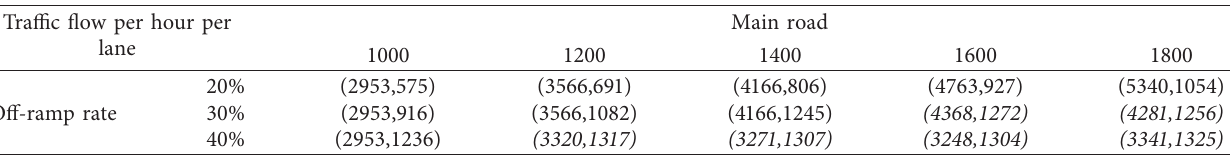
Figure 8: The average vehicle delay change curves of strategy A2.1 and strategy A2.2 at different off-ramp flow. (a) 20%. (b) 30%. (c) 40%. Table 1: Actual traffic flow through detection nodes in different simulation conditions (main road total traffic flow and off-ramp traffic flow).